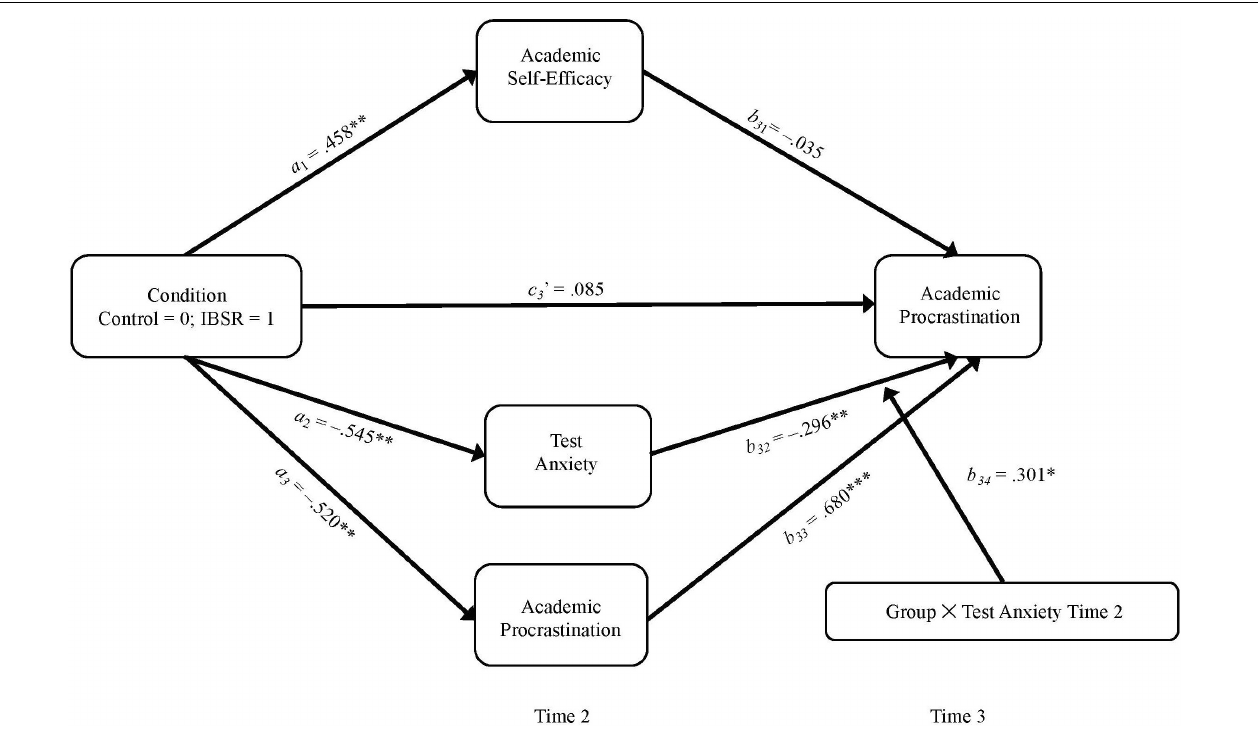
FIGURE 2 | Conditional Parallel Multiple Mediation Models for Academic Procrastination Measured at Time 3. All continuous variables were z -standardized. All reported parameter estimates are unstandardized. N = 71. † p ≤ 0.10, ∗ p ≤ 0.05, ∗∗ p ≤ 0.01, ∗∗∗ p ≤ 0.001. Reported are significance levels based one-tailed p